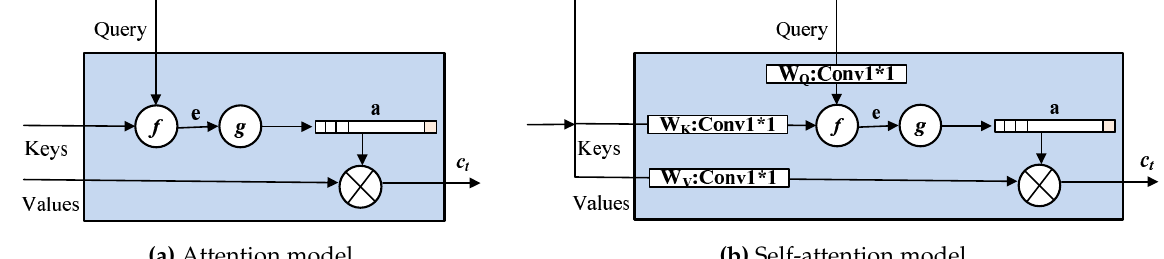
Figure 4. Attention